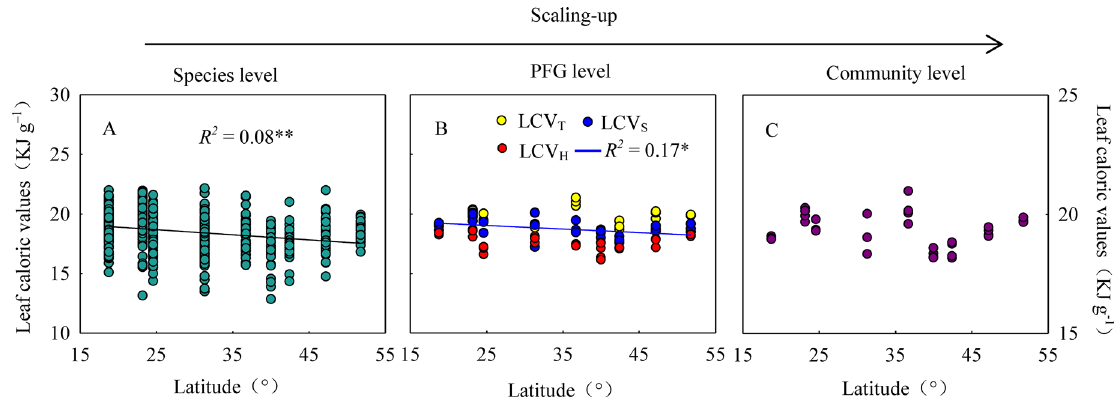
Fig 4. Latitudinal trends of leaf caloric values at the species, plant functional group (PFG), and community levels in Chinese forests. LCV T , LCVs, and LCV H , the average of leaf caloric value for the relative leaf biomass of trees, shrubs, and herbs, respectively. Only significant regression ( p < 0.05) is given. * , p < 0.05; ** , p < 0.01.